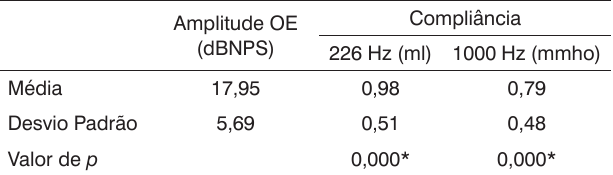
Tabela 4. Comparação entre amplitude da EOAT e a compli- ância em 226 Hz e 1000 Hz na OE.